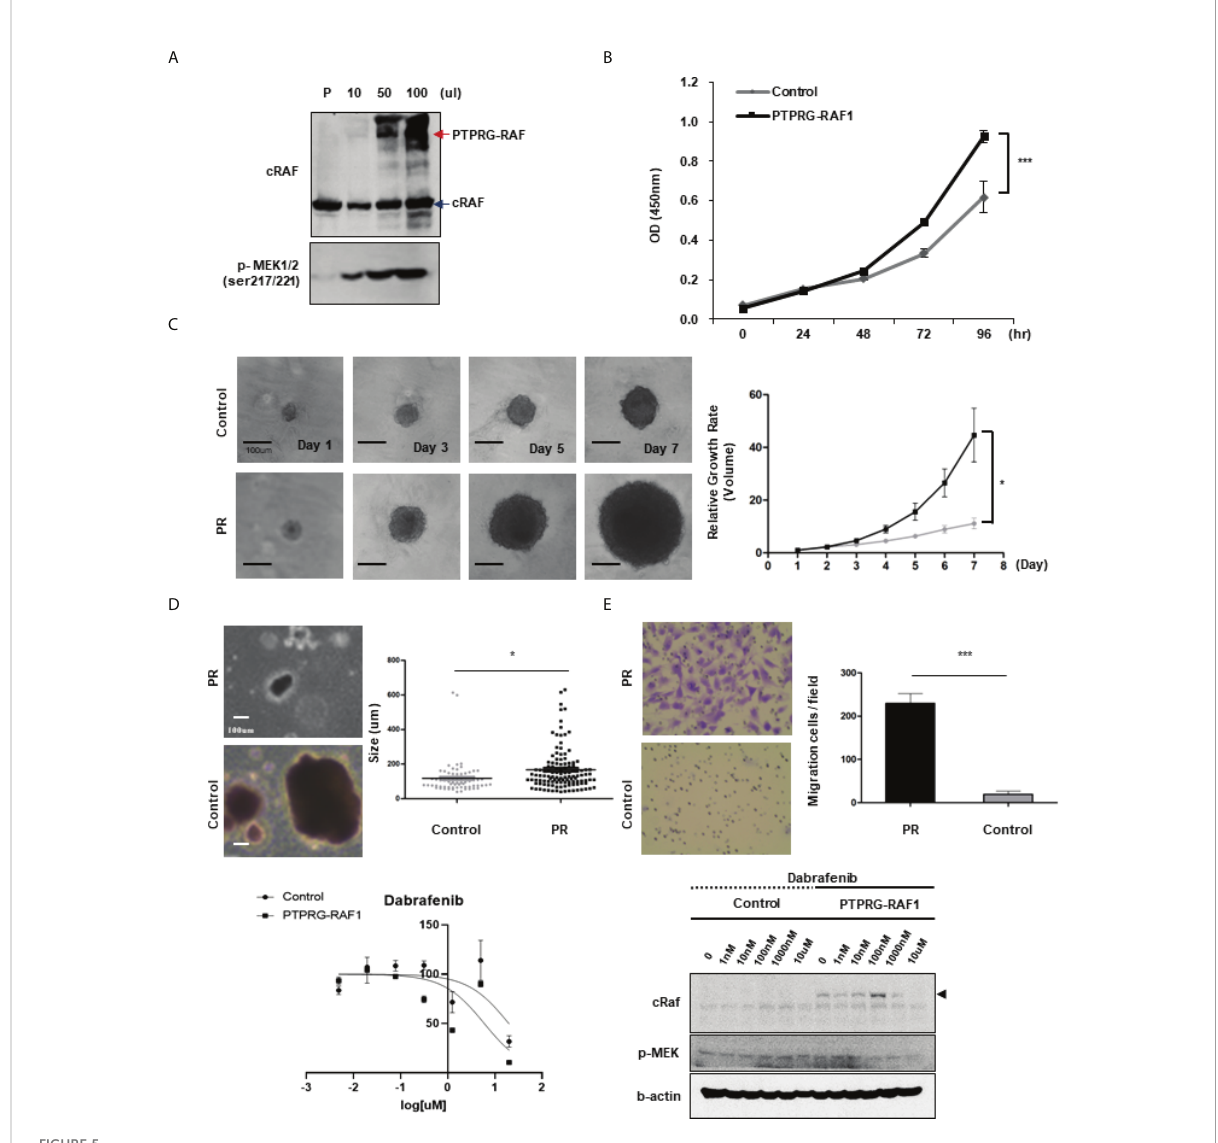
FIGURE 5 Oncogenicity of PTPRG - RAF1 . (A) Western blotting showing RAF1 expression in the parental cell line (293FT), with an PTPRG-RAF1 fusion of 140 kDa and phospho-MEK1/2 expressed in 293FT cells transfected with the PTPRG -RAF1 expression plasmid. (B) Proliferation of NIH3T3 fusion- expressing cells (PR cells) by MTS assay (p<0.001). (C) Proliferation of PR cells assessed in spheroid culture, and relative growth rate in 3D culture condition. Clones were taken images and measured the diameters, and the volume was calculated using the formula described in the method (p<0.0001). (D) In vitro transforming assay in soft agar. NIH3T3 control and PR cells were cultured for 14 days in soft agar. The size of colonies was measured. *p < 0.05. (E) Invasion assay conducted in control and PR cells (p<0.001) (F) High throughput screening for antiproliferative activity; only dabrafenib showed a response (IC 50 approximately 1 µM). (G) Effect of dabrafenib treatment in PR expressing cells. Cells were treated with the indicated concentrations of dabrafenib and after 72 h, cells were lysed and expression of the indicated proteins was assessed by western blot.